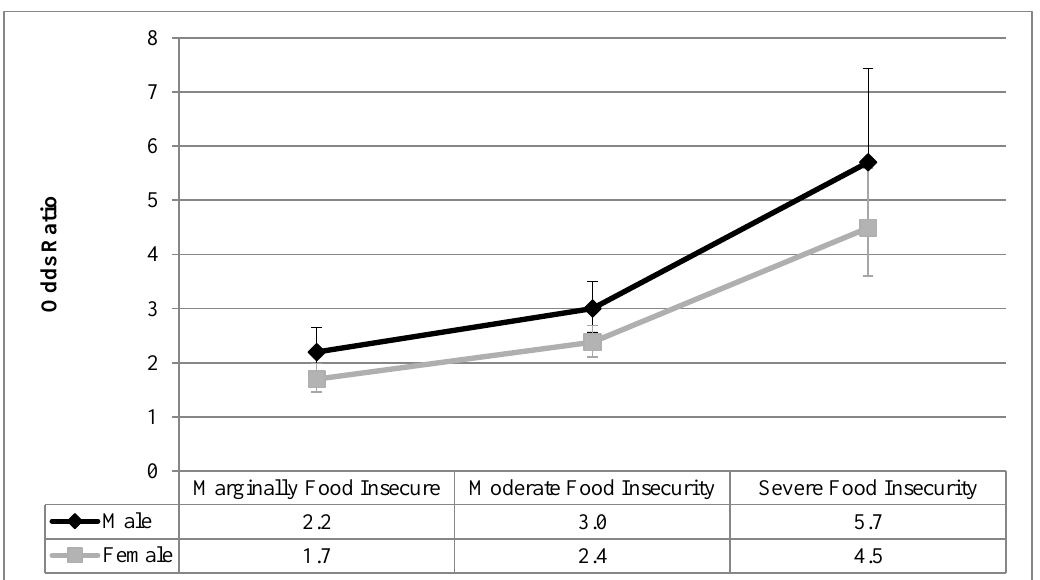
Figure 2. Odds ratio of reporting anxiety disorders for each level of household food insecurity stratified by sex, compared with food secure; results from reduced binary logistic regression.